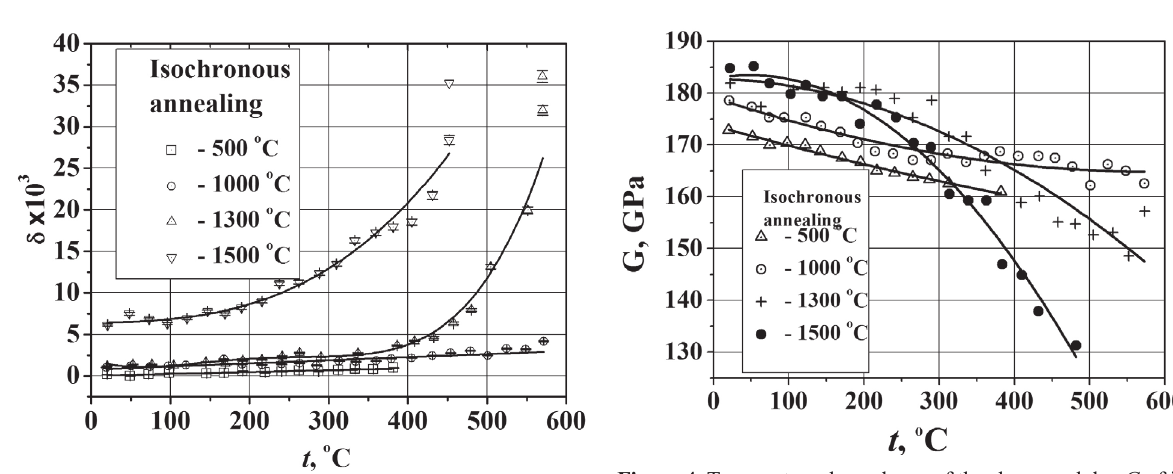
Figure 3. Temperature dependence of internal friction ∆ of irra- diated rhenium for various isochronous annealing temperatures.